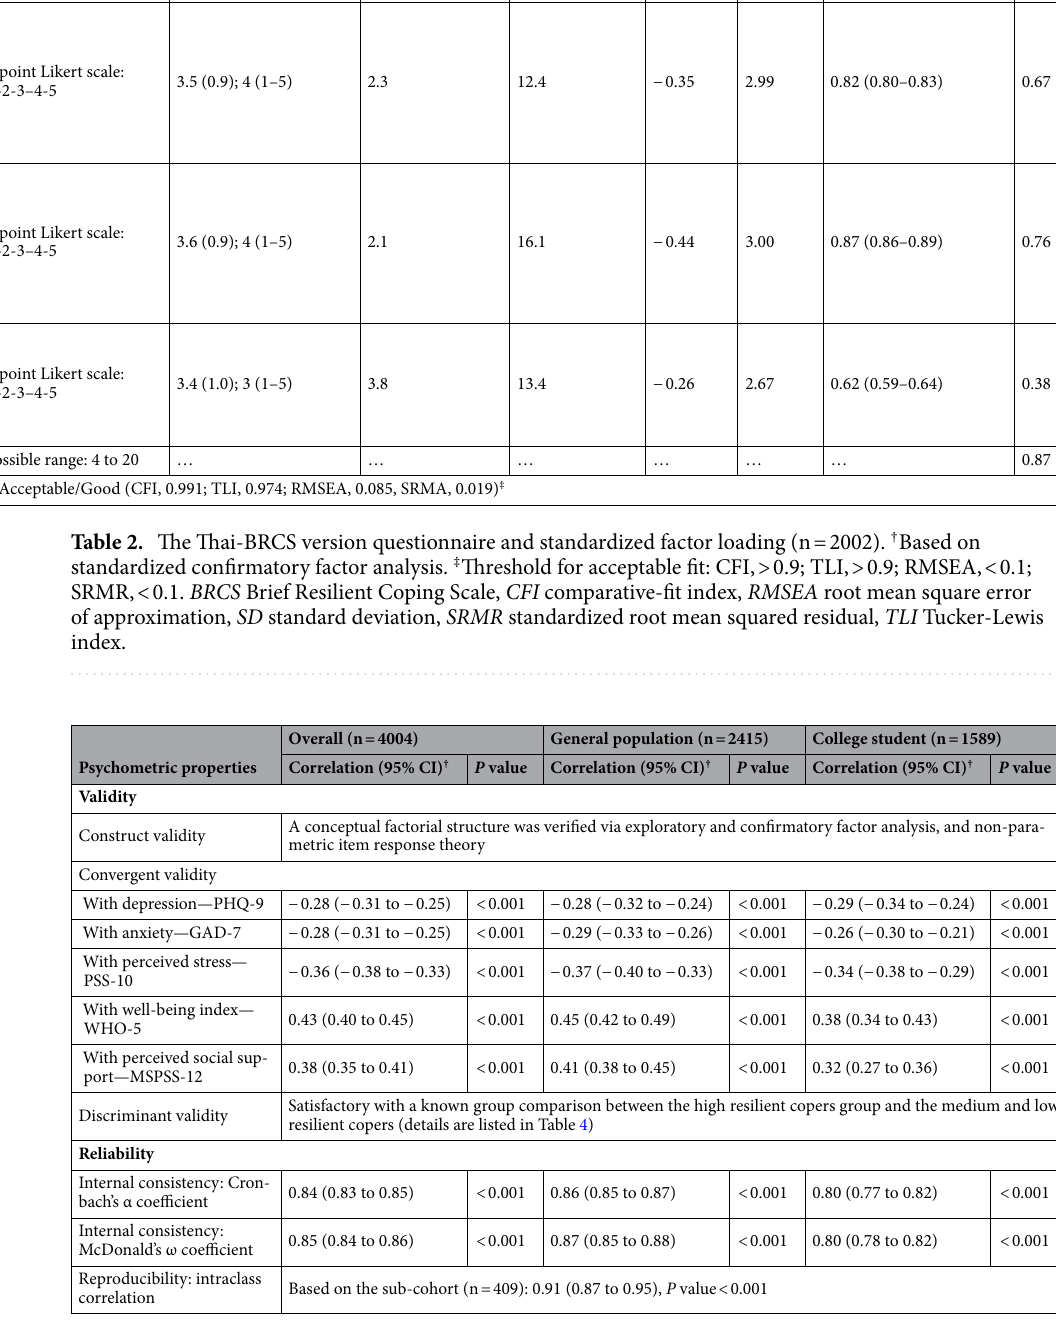
Table 3. Psychometric properties of the Thai-BRCS version questionnaire. † Pearson or Spearman rho correlation test. BRCS Brief Resilient Coping Scale—4-items, CI confidence interval, GAD-7 Generalized Anxiety Disorder—7-items, MSPSS-12 Multidimensional Scale of Perceived Social Support—12-items,